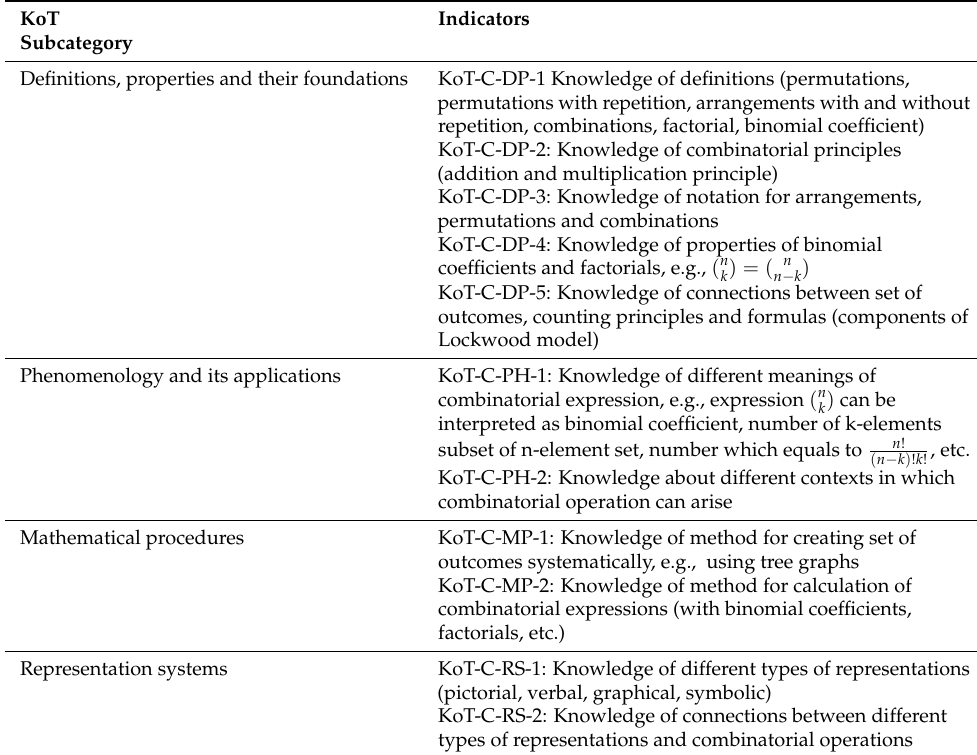
Table 5. Categories and indicators of combinatorial knowledge of